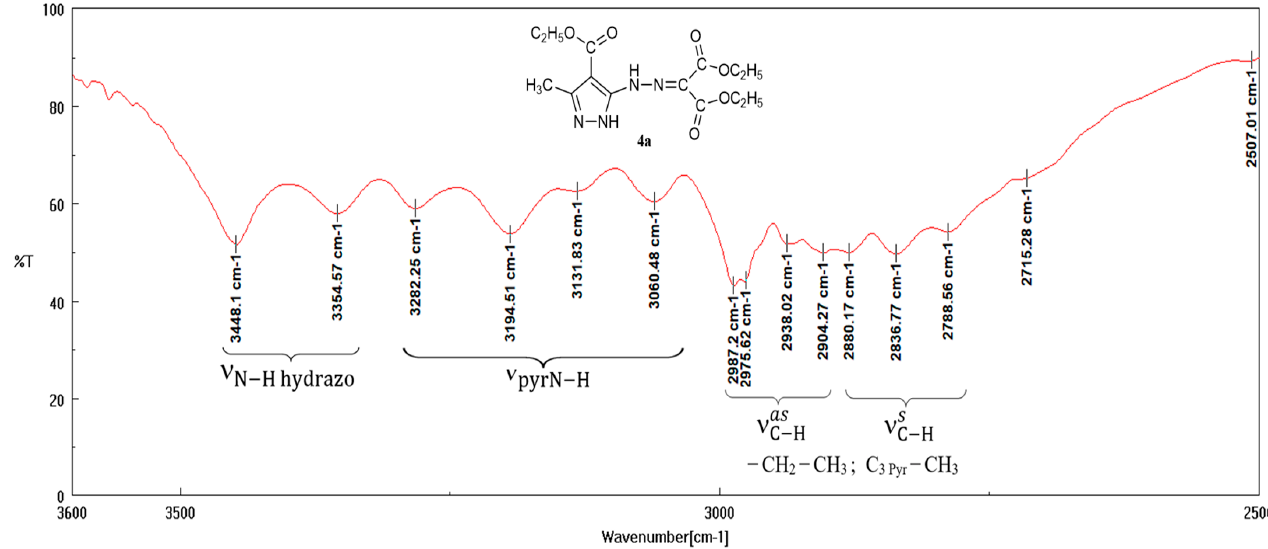
Figure 1. Enlarged (3600–2500cm − 1 ) FT-IR spectrum of 4a .